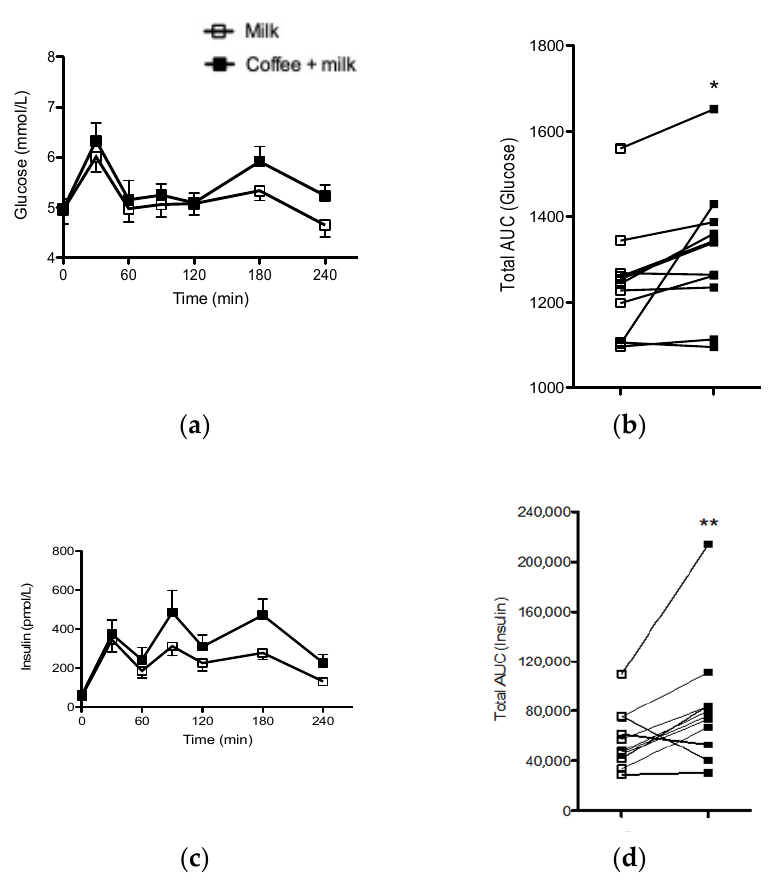
Figure 5. Glycemic ( a ) and insulinemic curve ( c ) in the seven time points during the 4-h recovery; individual glucose ( b ) and insulin ( d ) TAUC of healthy endurance-trained adult men treated or not with coffee. * p = 0.02 for glucose TAUC (coffee + milk vs. Milk); ** p = 0.03 for insulin TAUC (Coffee + milk vs. Milk). Repeated procedure method, Proc Mixed (SAS studio).